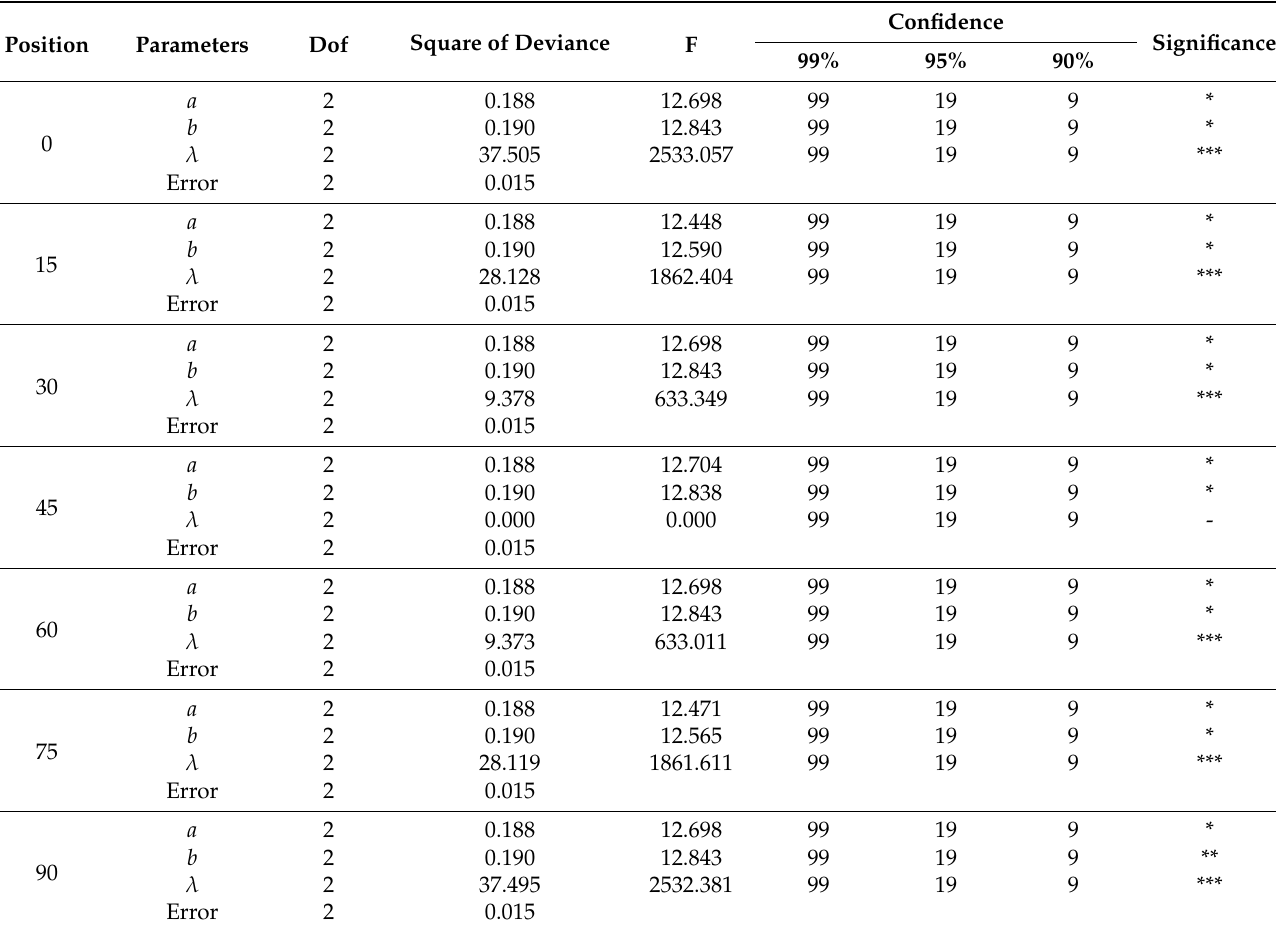
Table 7. Variance analysis of influence factors of section